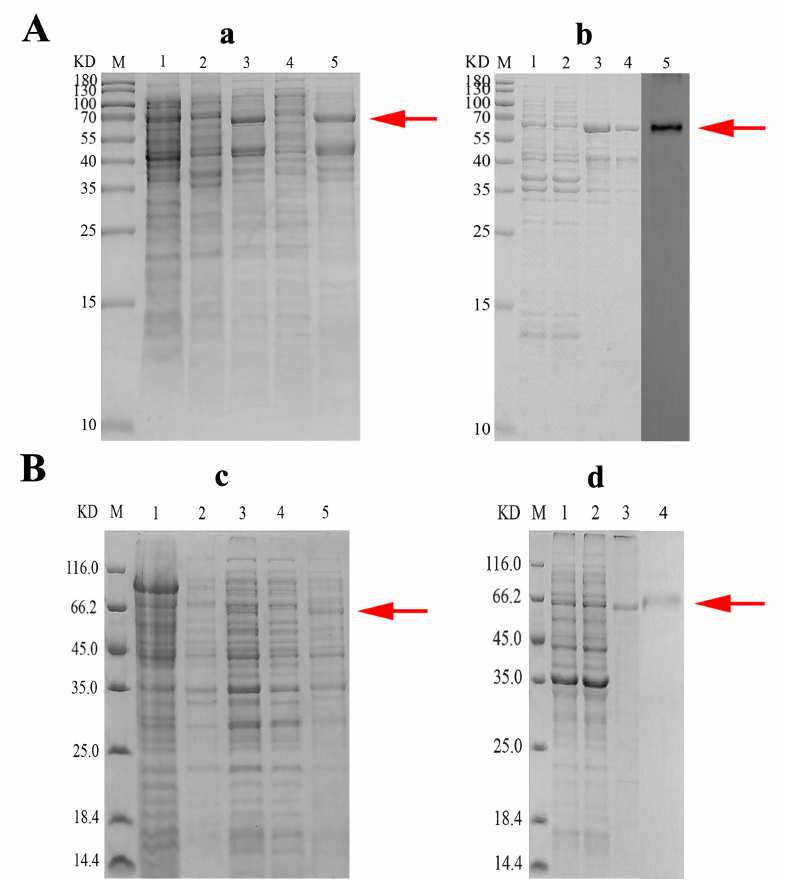
Figure 6. Expression and purification of rToBPI1/LBP ( A ) and rToBPI2/LBP ( B ); ( a , c ): Lane